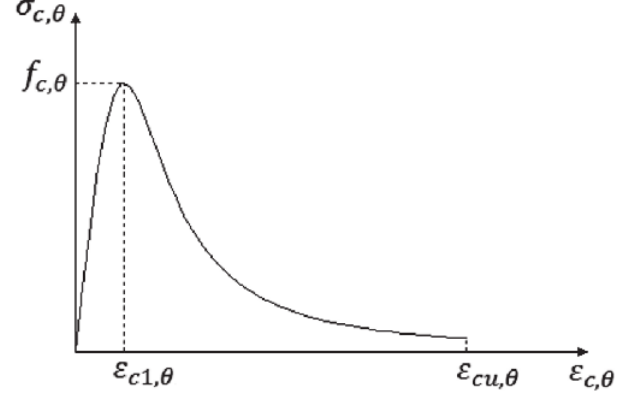
Figura 10 Diagrama tensão-deformação do concreto